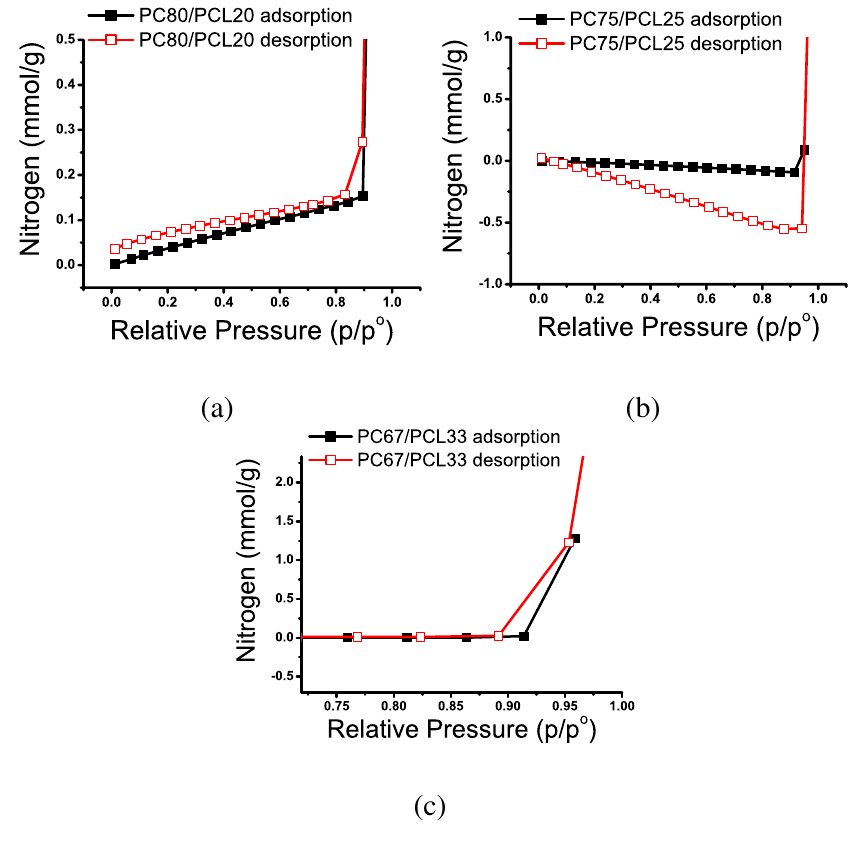
Figure 7. BET isotherms: (a)PC80/PCL20 (b)PC75/PCL25 (c)PC67/PCL33.